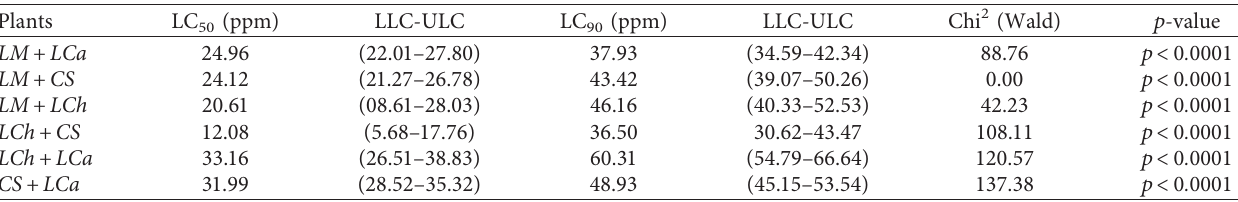
Table 8: The 50% and 90% lethal concentrations (LC 50 and LC 90 , respectively), their 95% confidence intervals, and regression parameters of the larvicidal activity of essential oils mixture against Culex quinquefasciatus 24h post